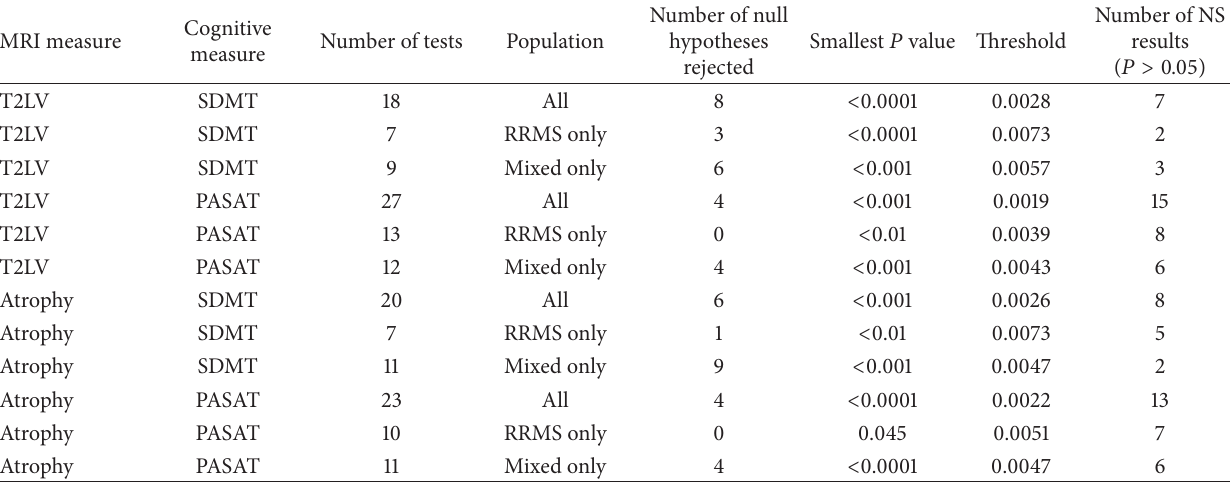
Table 1: Holm-Bonferroni Investigation into the relationships between whole-brain MRI measures and information processing tests. MRI